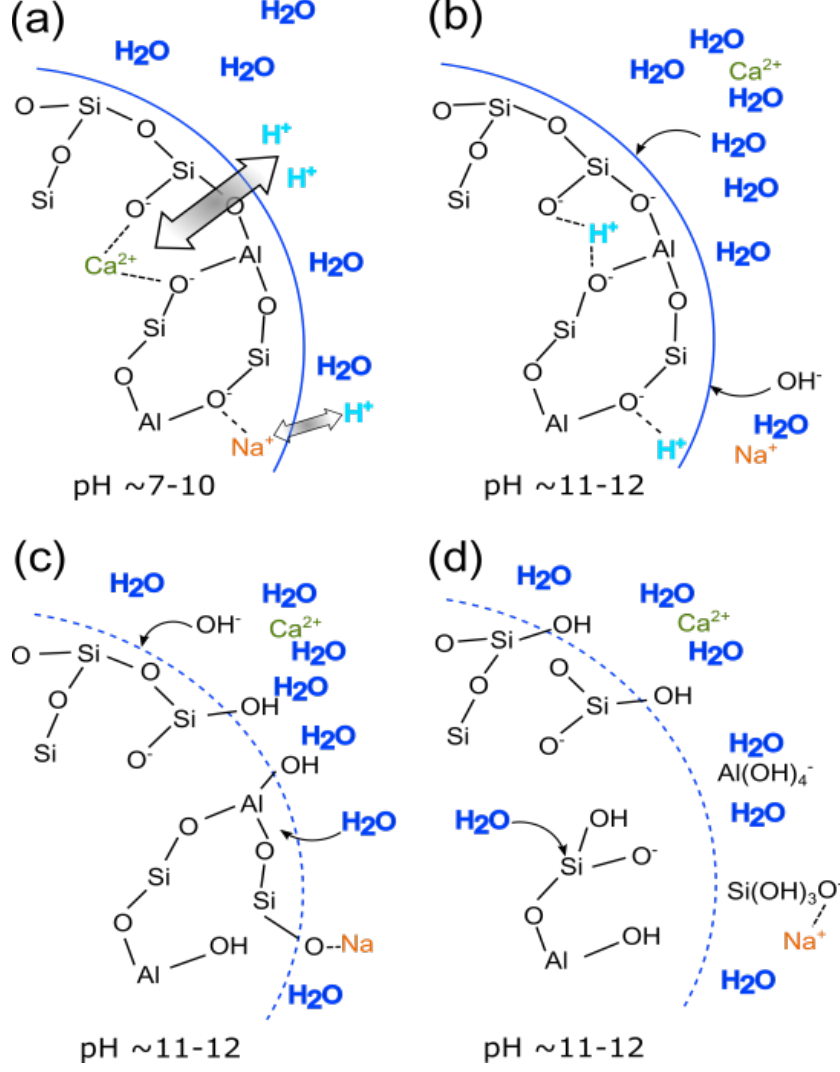
Figure 3. Dissolution mechanism of alkali activation of slag at early stage of ( a ) shifting of H + to Ca 2+ and Na + , ( b ) hydrolysis of Al-O-Si bonds, ( c ) breakdown of the depolymerized glass network, and ( d ) Si and Al detached from the network [126].